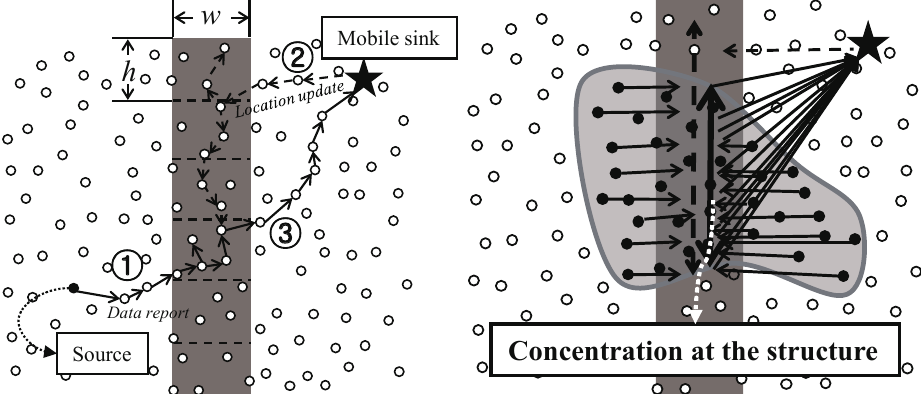
Figure 6. Examples of object tracking in LBDD: ( left ) individual object tracking and ( right ) continuous object